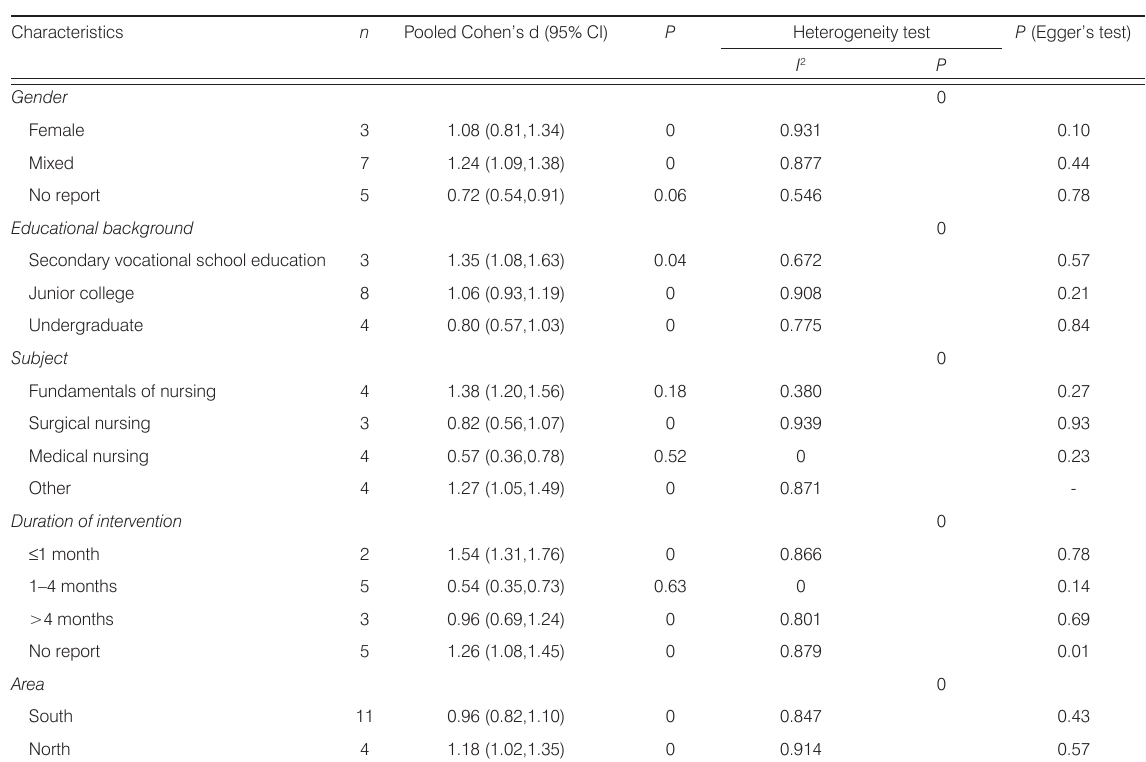
Table 4. Subgroup